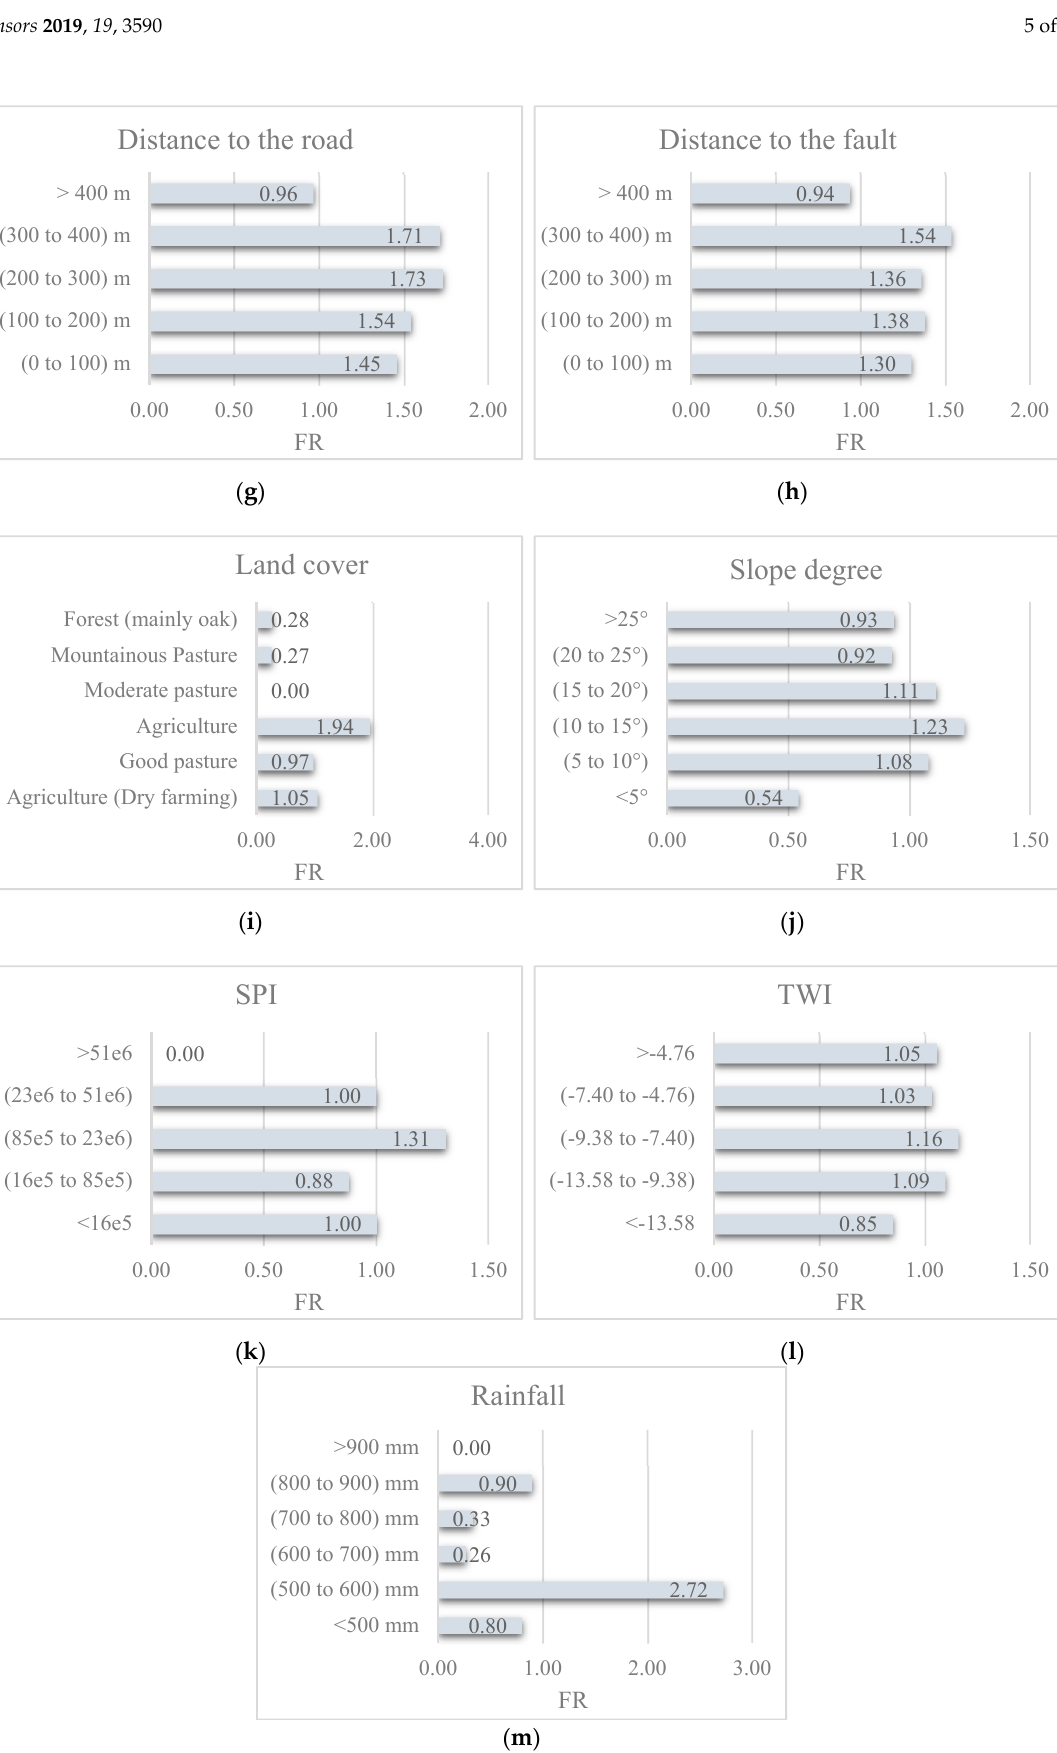
Figure 2. The calculated frequency ratio(FR) for ( a ) elevation, ( b ) slope aspect, ( c ) plan curvature, ( d ) profile curvature, ( e ) soil type, ( f ) distance to river, ( g ) distance to road, ( h ) distance to fault, ( i ) land cover, ( j ) slope degree, ( k ) SPI, ( l ) TWI, and ( m )